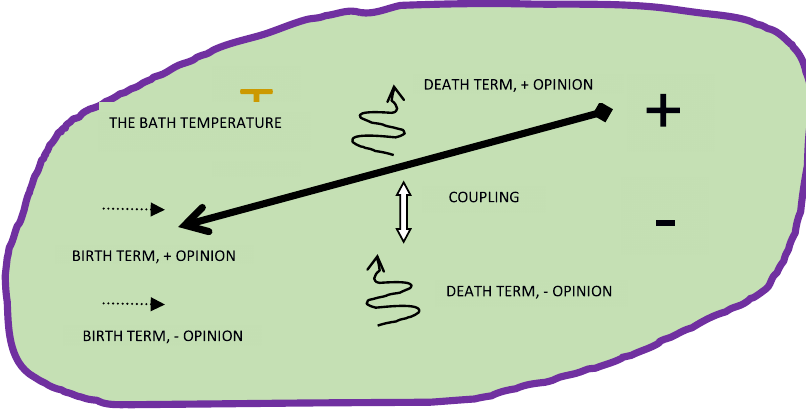
Fig. 1. A schematic illustration of thesociety-deciders model. The whole structure is representing the nation: the society and the deciders; within the structure, the \bulk" is thesociety, represented with a temperature T , and the society-top, the \deciders", are represented through the potentials' curves (the inclined curves), where thearrows show deciders °ow [either from the system (curly arrows) or between opinions, or inside the system (broken